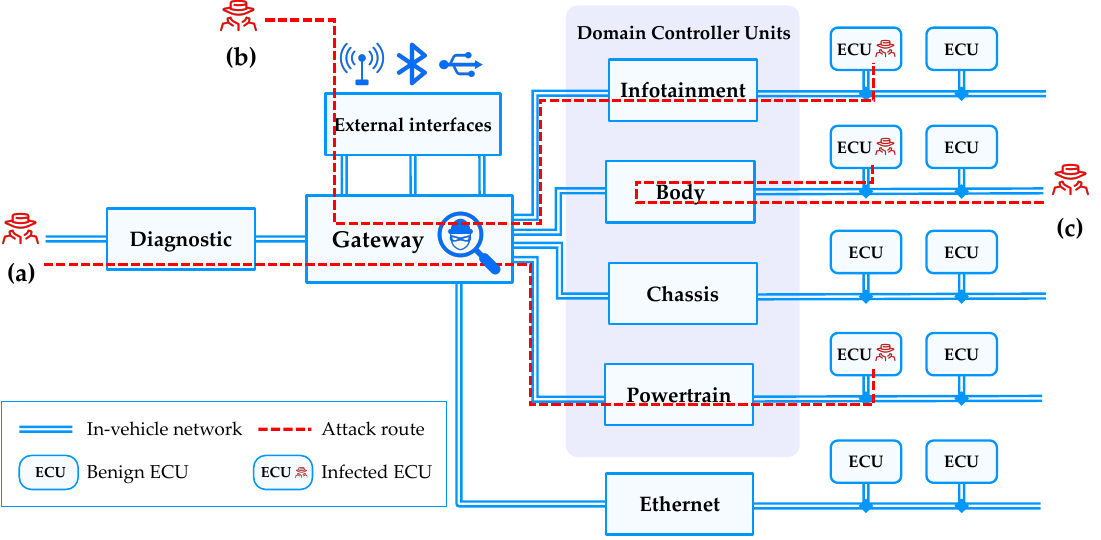
Figure 2. CAN topology and attack vectors: ( a ) external interfaces; ( b ) diagnostic bus; and ( c ) occupation of CAN